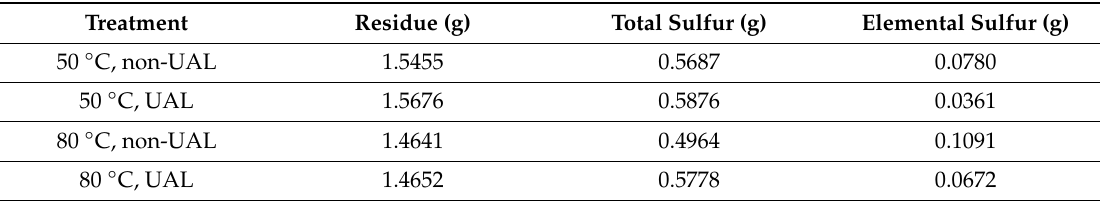
Table 2. Mass of the sulfur species in the chalcopyrite residues from leaching at two temperatures without (non-UAL) and with (UAL) ultrasound